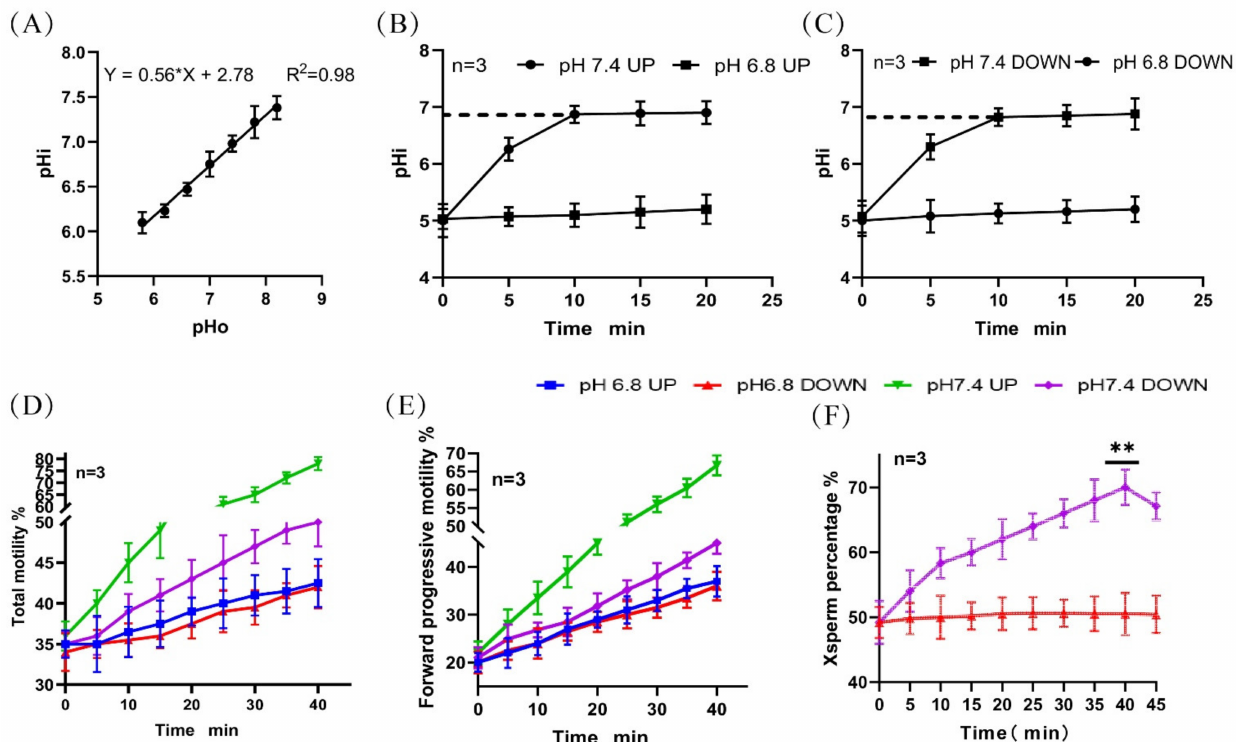
Figure 1. Changes in pHi and motility activity during sperm incubation. ( A ) Standard curve of